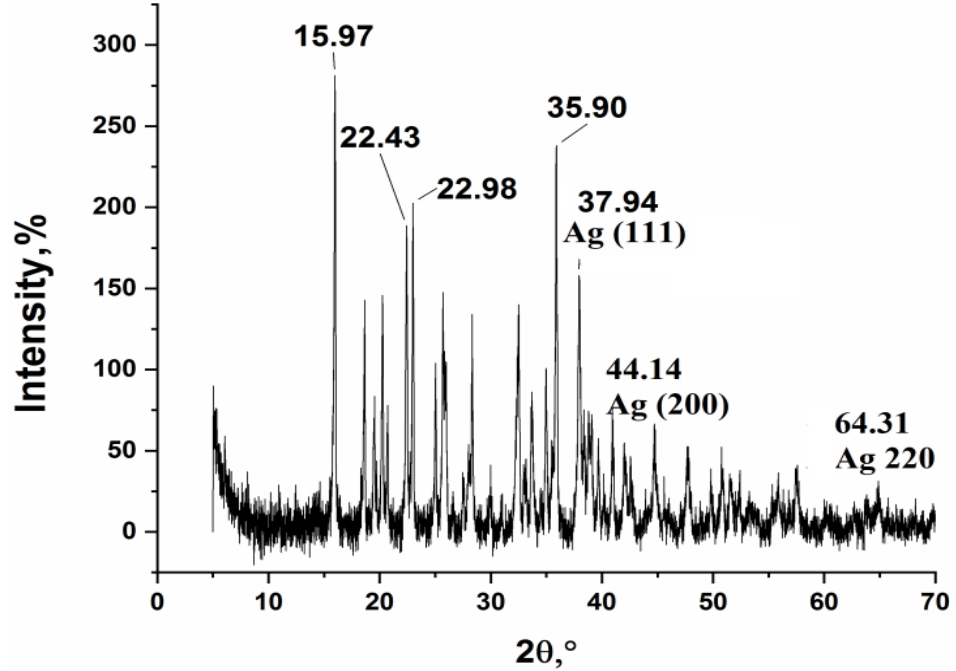
Figure 14. XRD of a sample of the thermolysis product of silver maleate in xylene.